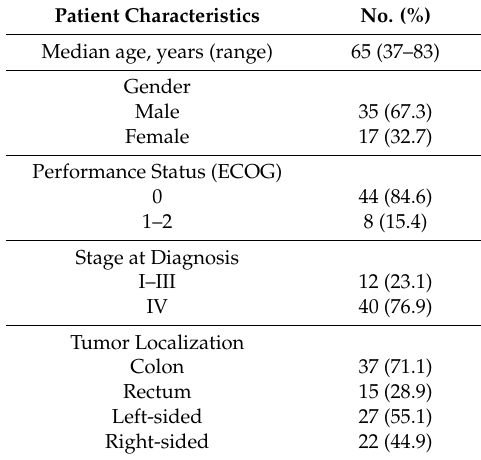
Table 1. Patient characteristics ( n =